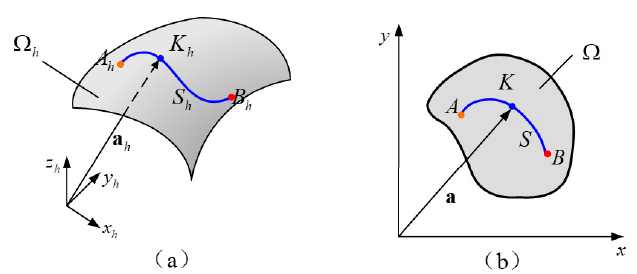
Figure 2. Ultrasonic guided wave propagation path in different coordinate systems of ( a ) the 3-D surface of elbow and ( b ) the 2-D mapped surface.